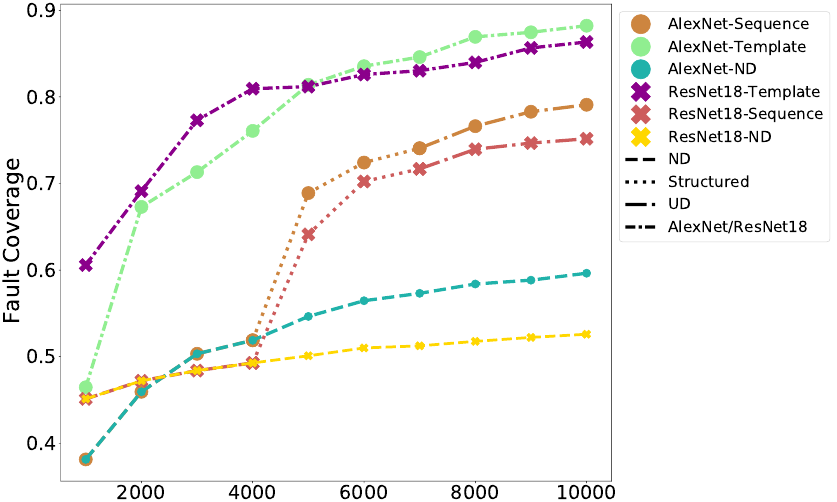
Figure 9. Fault coverage achieved using templates versus baselines for AlexNet & ResNet-18 trained on